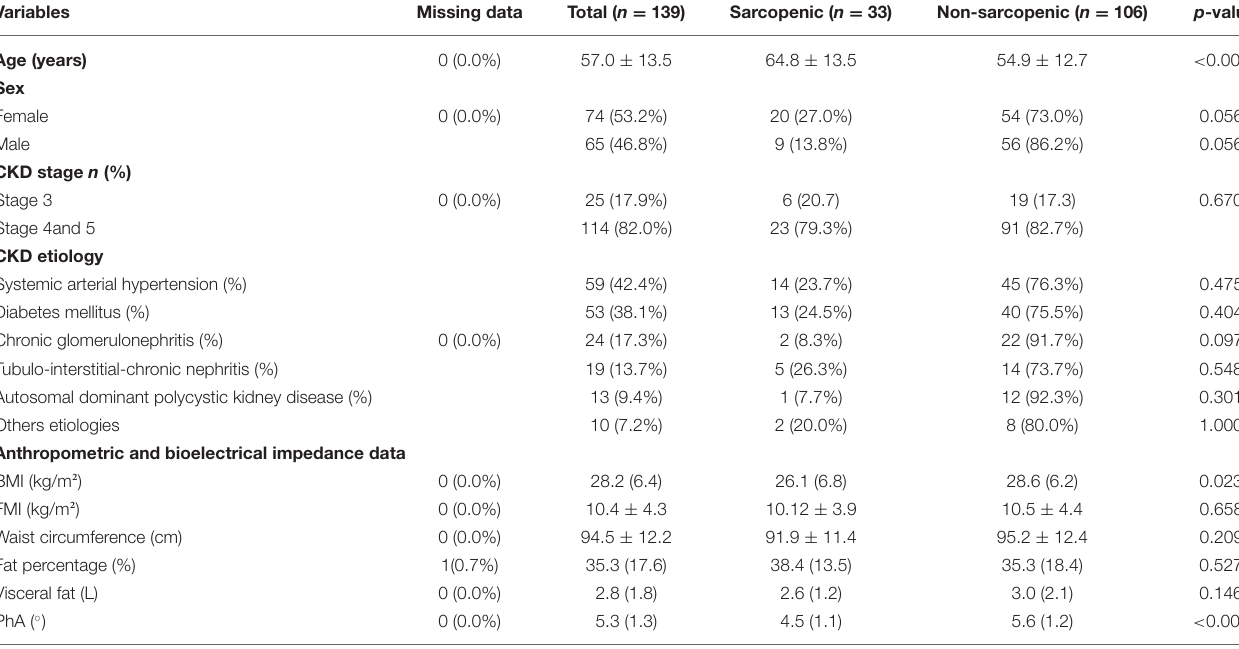
TABLE 1 | Distribution of sarcopenia according to sociodemographic, clinical and body composition characteristics in the CKD study population. Variables Missing